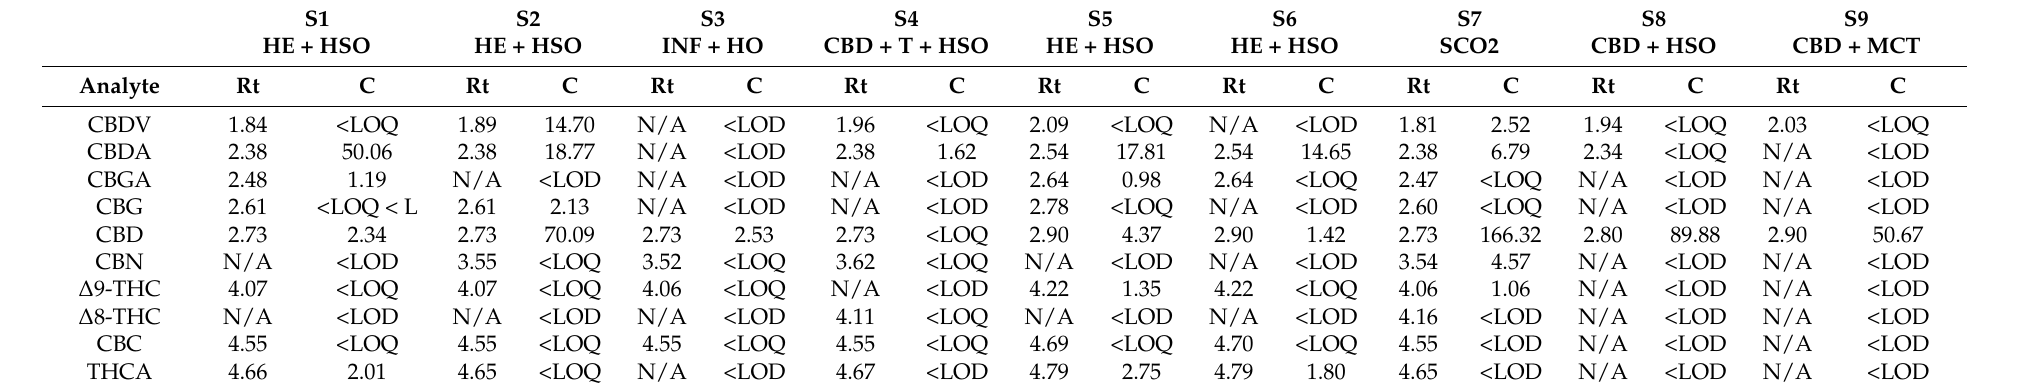
Table 6. Results for hemp oils, analyzed with the proposed method and regression equations used for